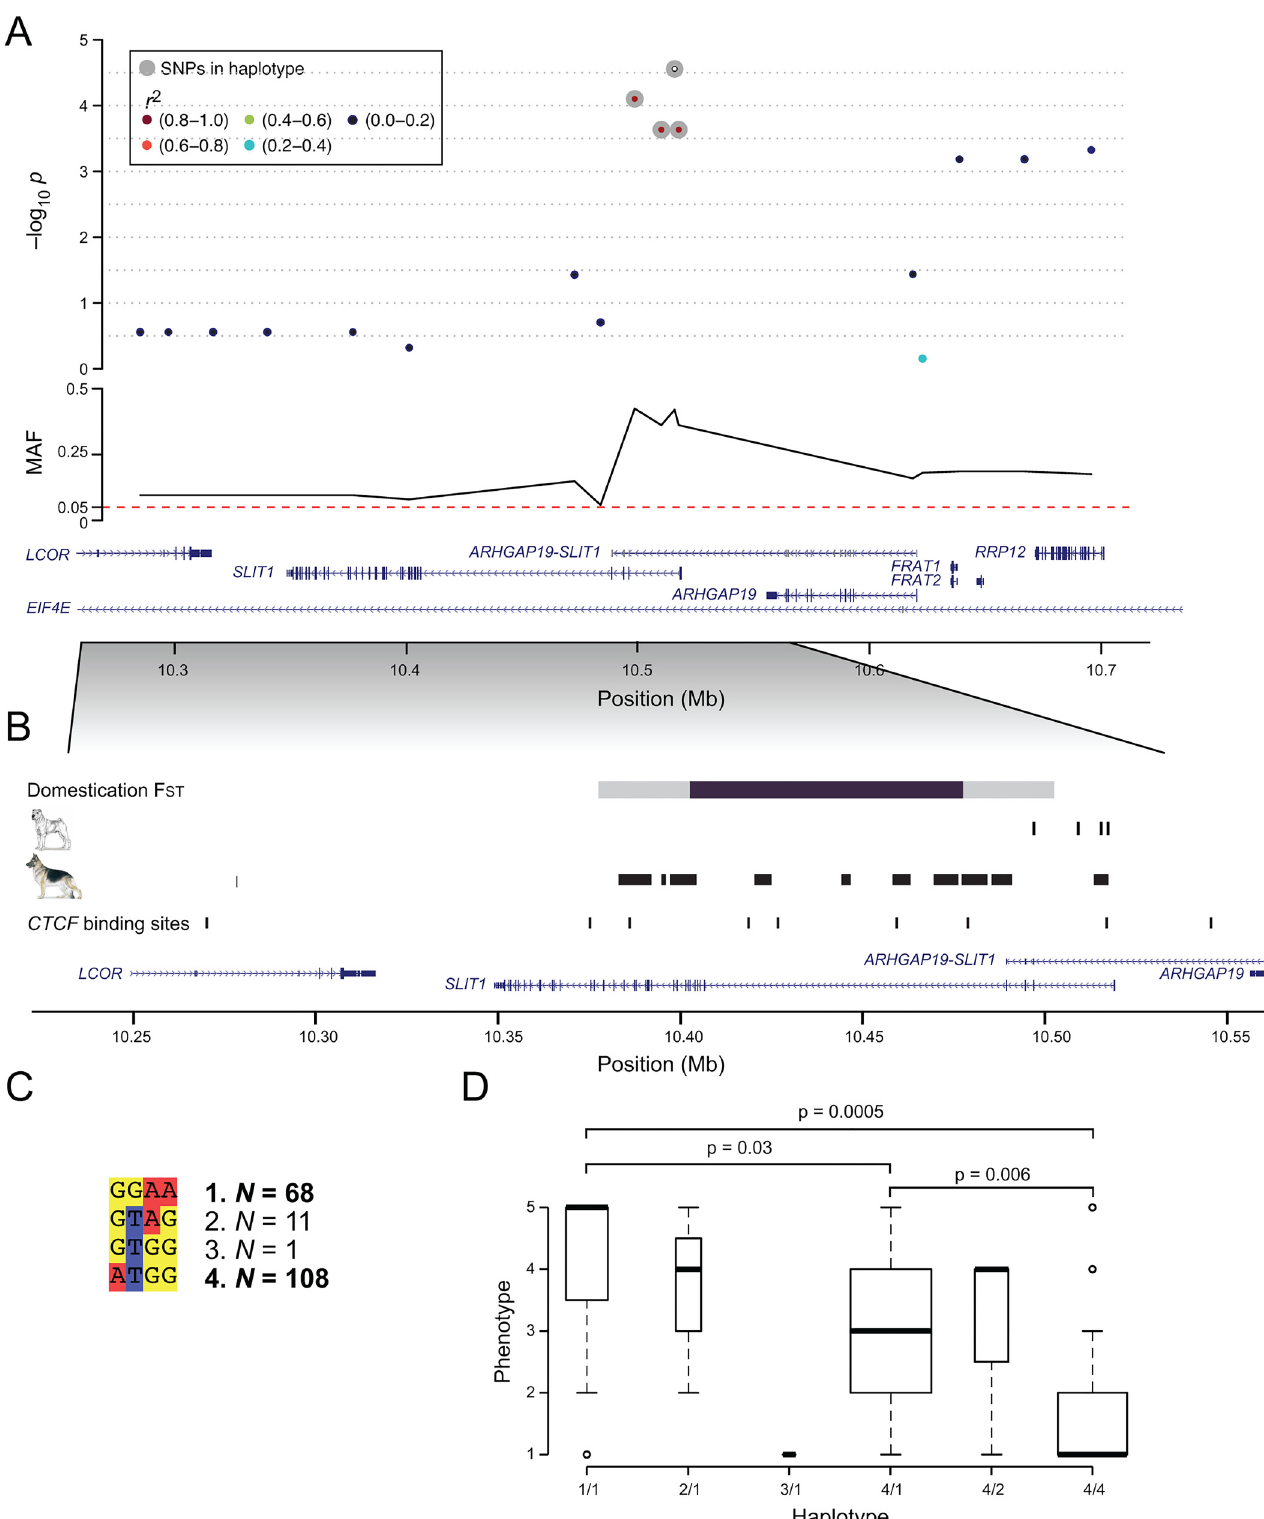
Fig 3. The SLIT1 gene harbours an associated haplotype in Shar-Pei and fixed blocks in German shepherd. (A) In SP, four SNPs (grey circles) suggestively associated to IgA levels, were located within the first intron of SLIT1 . (B) A distinct increase in the degree of genetic differentiation (F ST )